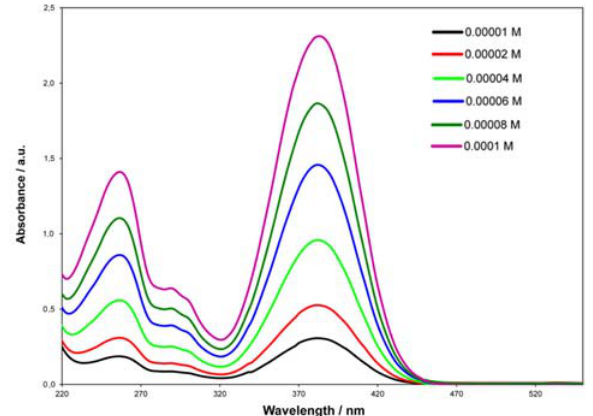
Fig. 2. Absorbance spectra of ITHBA of different molar concentra- tion